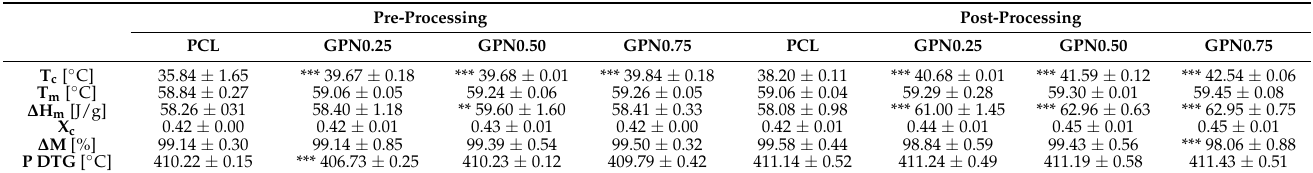
Table 2. Thermophysical properties of PCL-based composites obtained from DSC and TGA: T c ; T m ; ∆ H ∆ M ; P DTG . Two-way ANOVA, uncorrected Fisher’s LSD ( n = 3), multiple comparisons to m ; X c ;